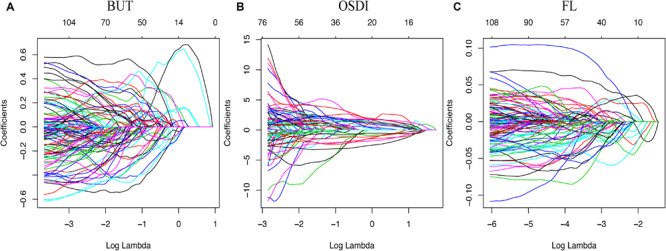
Model for least absolute shrinkage and selection operator (LASSO). Color lines represent the metabolites potentially associated with dry eye. The x-axis represents the alpha (cutoff), and the y-axis represents the shrink effect value.